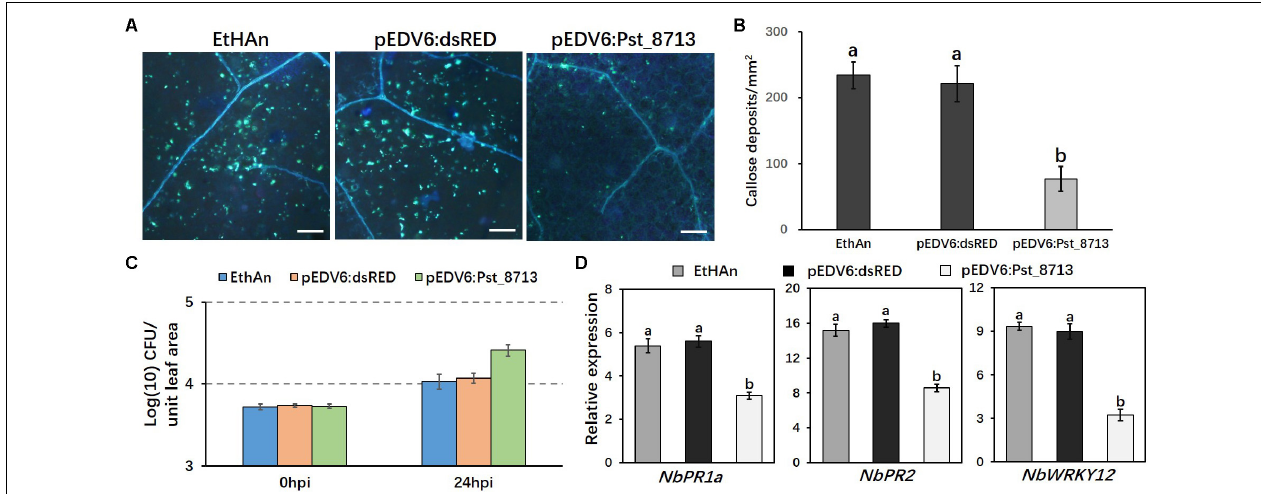
FIGURE 6 | Overexpression of Pst_8713 in N. benthamiana suppressed expression of PTI-related marker genes. (A) Callose deposition in leaves of N. benthamiana inoculated with EtHAn, pEDV6:dsRED, and pEDV6:Pst_8713 stained with aniline blue. Bar = 200 µ m. (B) The average number of callose deposits in tobacco leaves expressed with pEDV6:dsRED or pEDV6:Pst_8713. Bars indicate means ± SE of three independent biological replicates with 30 unit areas per replicate. The different letters indicate significant differences ( P < 0.05) according to ANOVA. (C) Bacterial growth in EtHAn, pEDV6:dsRED, or pEDV6:Pst_8713 infiltrated tobacco leaves. Numbers of bacteria were evaluated at 0 and 24 hpi. Each time-point is average of three biological replicates. Bacteria in tobacco inoculating EthAn carrying pEDV6:Pst_8713 grew ∼ 2.2-fold better than EthAn carrying pEDV6:dsRED at 24 hpi. (D) Transcription level fold changes of plant defense-related genes PR1a , PR2, and WRKY12 in leaves of N. benthamiana transformed with pEDV6: dsRED or pEDV6: Pst_8713 at 24 hpi with EtHAn. NbActin was used as the internal reference gene. Bars indicate means of three independent biological replicates ( ± SE) and different letters indicate significant differences ( P < 0.05) according to ANOVA.